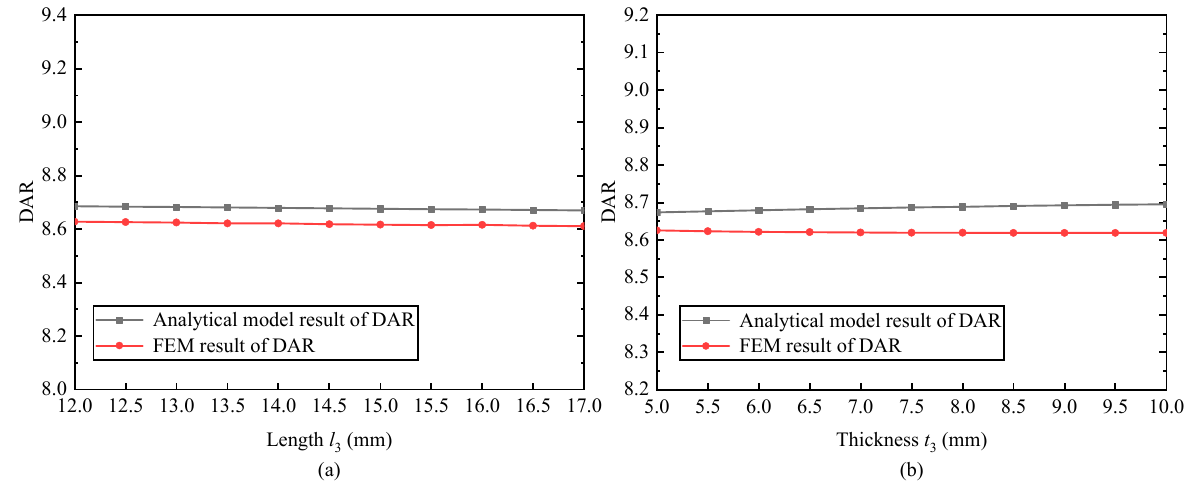
Figure 8. The changes in DAR with the output body varied. ( a ) The output body length l 3 . ( b ) The output body thickness t 3 .